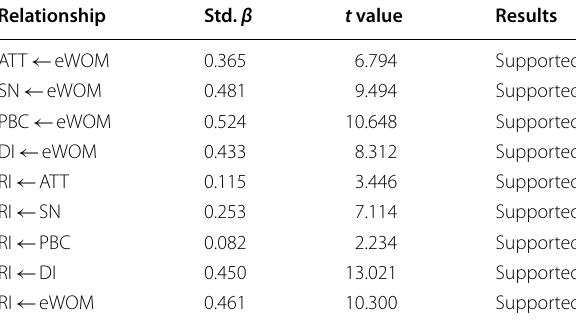
Table 7 Summarized hypotheses. Source : AMOS Output